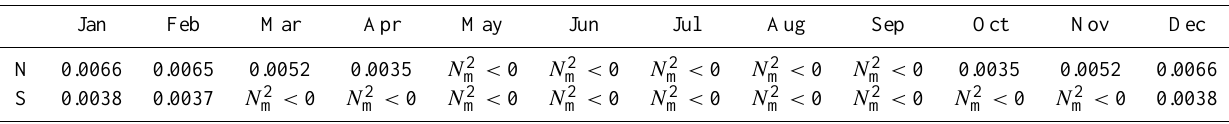
Table 1. Monthly estimates of squared moist Brunt–Väisälä frequency ( N 2 m ) for southern and northern side of the European Alps. Unreal cases ( N 2 m <0) indicate unstable atmosphere, while positive values indicate static stability.